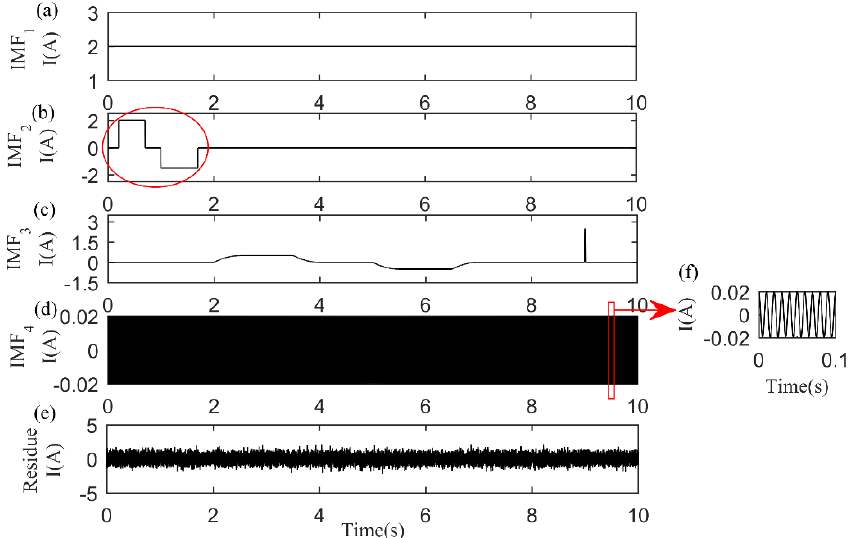
Energies 2021 , 14 , x FOR PEER REVIEW 17 of 28 Figure 16. MBMD decomposition diagram under the noise of SNR 10. ( a ) DC signal; ( b ) Wideband signal; ( c ) Narrowband signal; ( d ) Harmonic signal; ( e ) Noise signal; ( f ) A 0.1 s signal extract from ( d ).